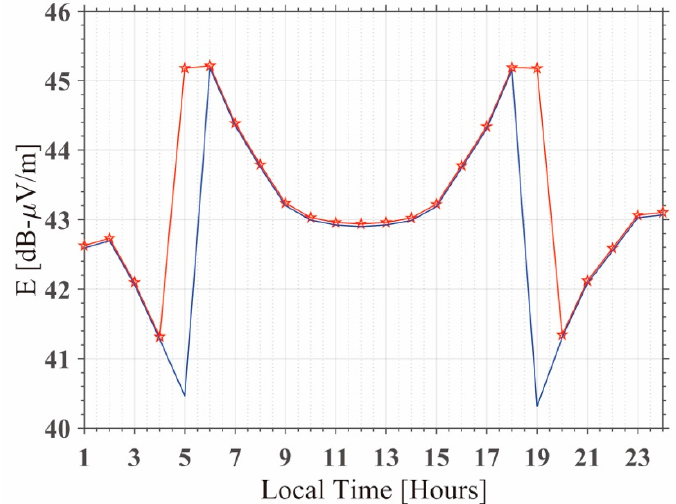
Figure 13. The calculated Ez component of the electric field 1,350 km away from the NWC transmitter with 19.8 kHz. The blue solid line shows the simulated result when the sunrise time was set at LT 5:00 and sunset was at LT 19:00. The red solid line with pentagrams shows the simulated result when the sunrise time was set at LT 4:00 and the sunset time was at LT 20:00.